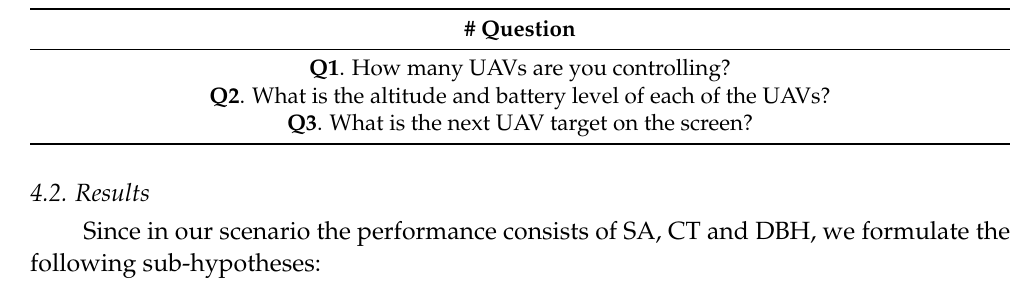
Table 1. Questions asked during the test to assess operator situational awareness.